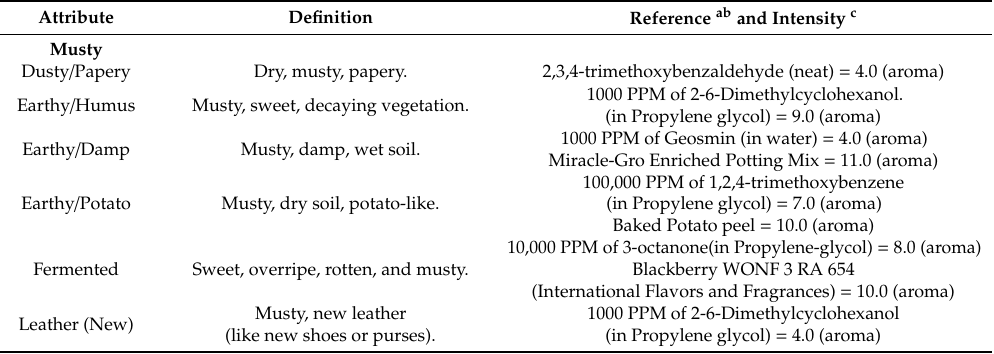
Table 2. Lexicon for flavor description of mushrooms studied in this